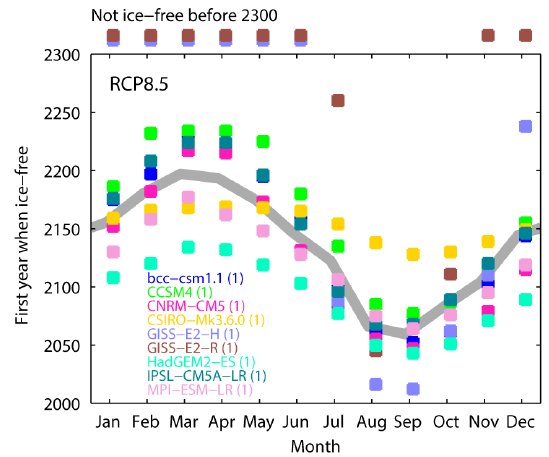
Figure 5. First date of sea ice-free conditions in the Arctic Ocean by month for RCP8.5. The months for which sea ice does not disappear during the simulation are given as symbols above the graph. The multi-model mean is shown by the thick gray line. Disappearance is the first year of at least 5 consecutive years where sea ice extent is < 1 × 10 6 km 2 , based on a 5-year running mean of sea ice